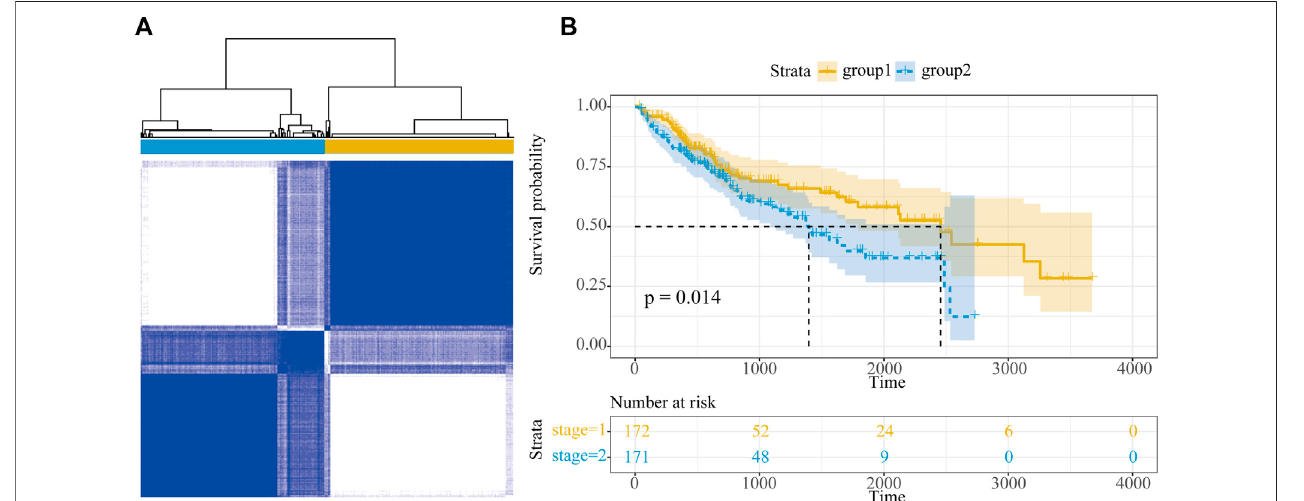
FIGURE 7 | Molecular subtype of HCC. (A) Subtype classi fi cation of HCC samples. (B) Survival curve of HCC